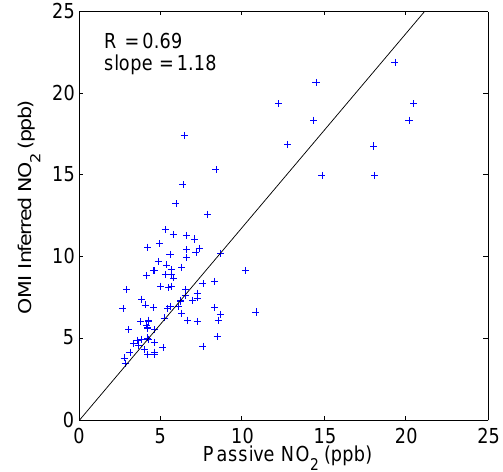
Fig. 9. Passive measurements taken during the BAQS-met cam- paign over 7 sampling periods at 17 simultaneous locations versus OMI inferred NO 2 concentrations at those same locations for the same